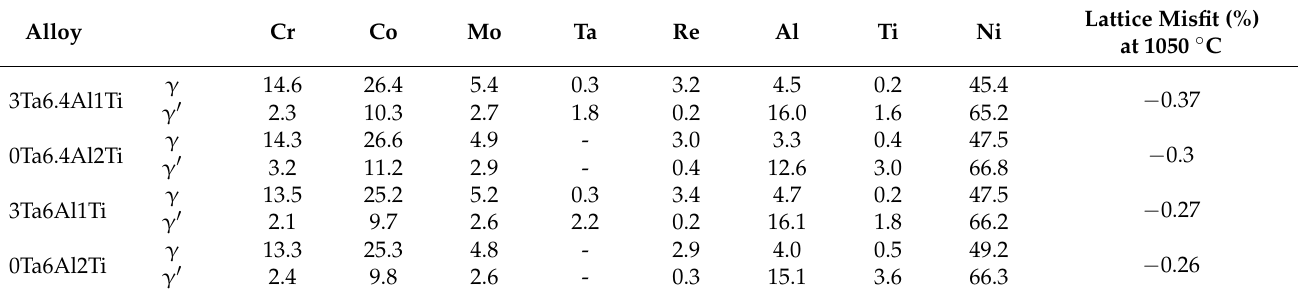
Table 2. Two-phase compositions (at.%) of four SX superalloys after the solid solution and two-step aging treatments and their lattice misfit at 1050 ◦